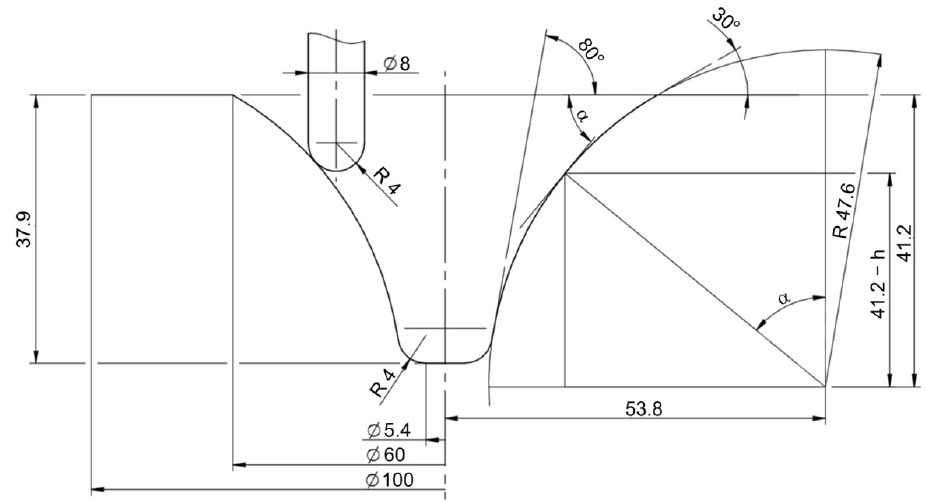
Figure 1. ( a ) Structural diagram and ( b ) view of experimental setup. The experiments stopped after fracture of the part. Height of drawpieces h was measured using height gauge. The maximum formable wall angle α was determined